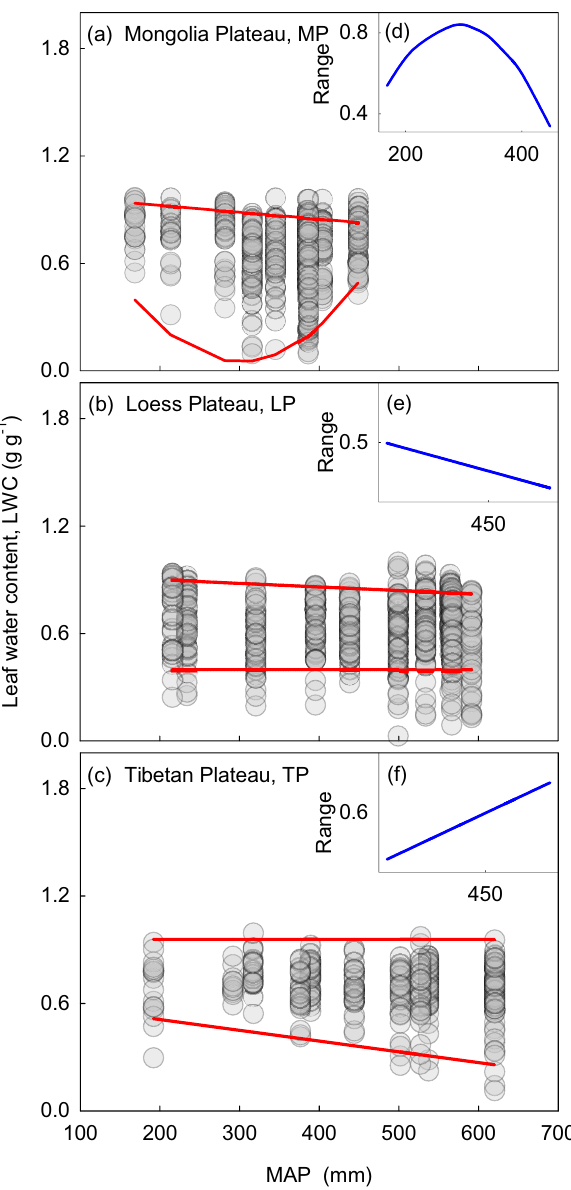
Figure 5. Range of leaf water content (LWC) in the community correlated with mean annual precipitation (MAP). Panels ( a ), ( b ) and ( c ) show the LWC in the community correlated with MAP in the Mongolia Plateau (MP), Loess Plateau (LP), and Tibetan Plateau (TP), respectively. Solid red lines indicate the linear regression analyses of 95% and 5% boundaries. Panels ( d ), ( e ), and ( f ) show the range of variation range in LWC with rainfall on the MP, LP and TP, respectively. Figures were done by SigmaPlot version